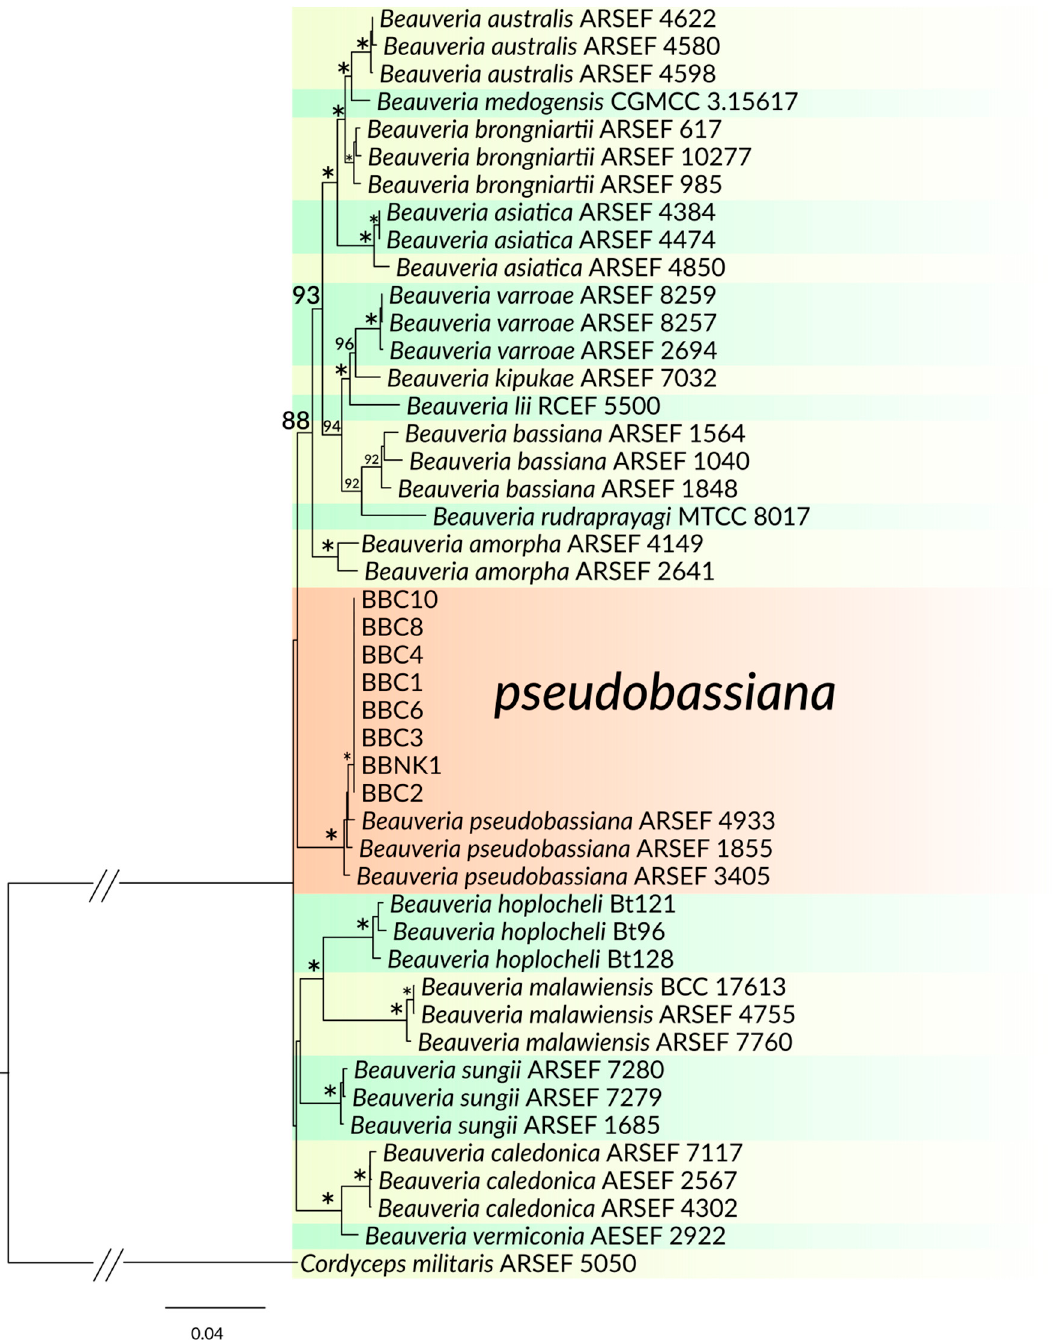
Figure 2. Maximum likelihood phylogenetic tree of selected isolated strains and related Beauveria species based on five loci (internal transcribed spacer (ITS)+Bloc+ translation elongation factor-1a (TEF)+RPB1+RPB2). Clades with newly isolated strains are highlighted in orange. Only bootstraps over 80% are shown. A bootstrap of 100% is indicated with an asterisk.